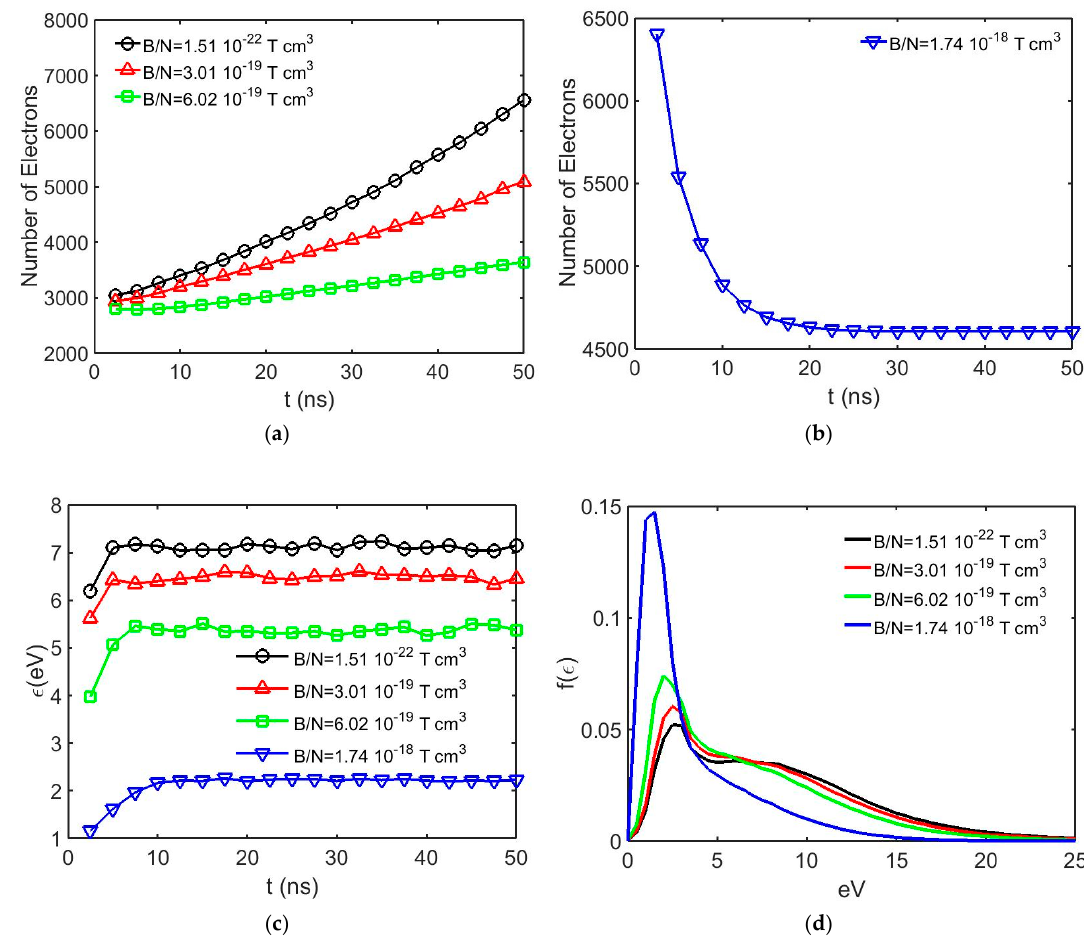
Figure 7. A 0.25% SF 6 + 99.75% N 2 mixture at 300 Td with different magnitudes of crossed magnetic field: ( a,b ) number of electrons; ( c ) electron mean energies; ( d ) electron energy distribution functions (Corresponding magnetic field strength; Black line: H = 3.99 A/m, Red line: H = 7.95 × 10 3 A/m, Green line: H = 1.59 × 10 4 A/m, Blue line: H = 4.60 × 10 4 A/m).